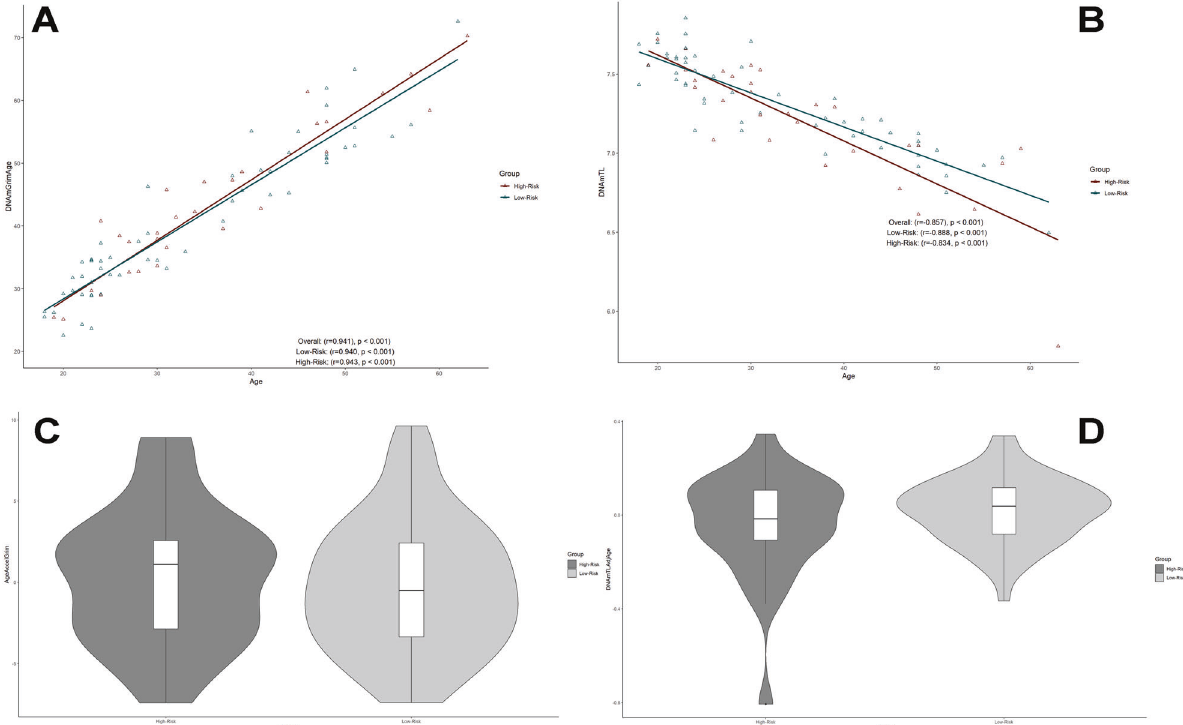
Fig. 3 Grim epigenetic age acceleration and DNA methylation-based telomere length. A , B Scatterplots show GrimAge or DNAmTL vs. chronological age. Pearson ’ s correlation analysis indicated a signi fi cant correlation between GrimAge/DNAmTL and chronological age in both groups. C , D Violin plot with boxplots shows Grim EAA or DNAmTLAdjAge. Student ’ s t -test showed no signi fi cant between-group differences. EAA, epigenetic age acceleration; DNAmTL, DNA methylation-based telomere length; DNAmTL AdjAge, age-adjusted DNAmTL.